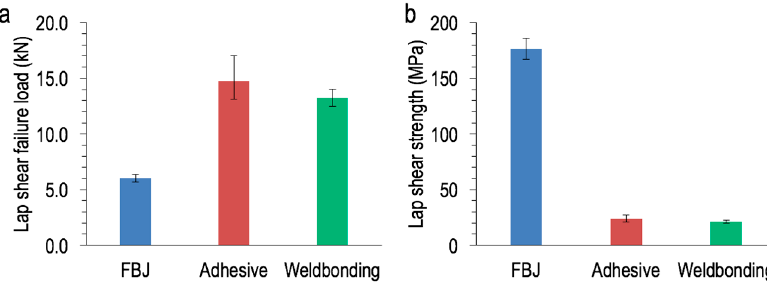
Figure 5. ( a ) Average lap shear failure load for FBJ, adhesive, and weld-bonded specimens. ( b ) Average lap shear strength of FBJ, adhesive-, and weld-bonded specimens.